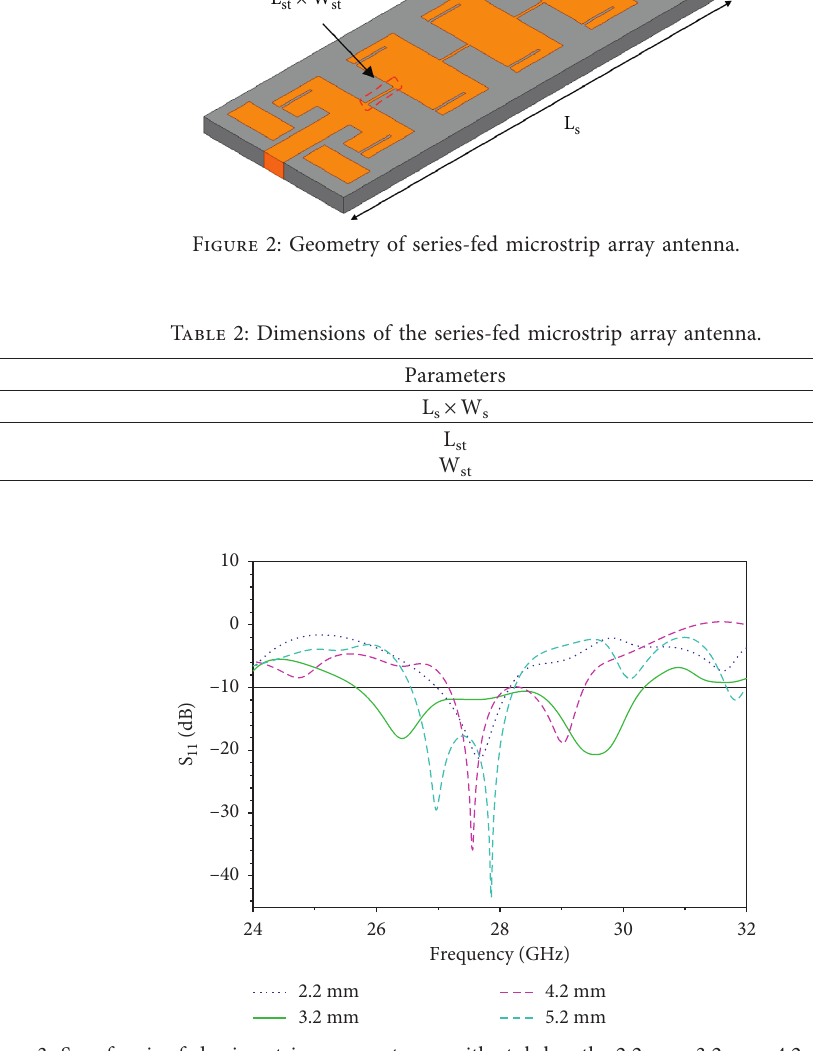
Figure 3: S 11 of series-fed microstrip array antenna with stub lengths 2.2 mm, 3.2 mm, 4.2 mm, and 5.2mm.